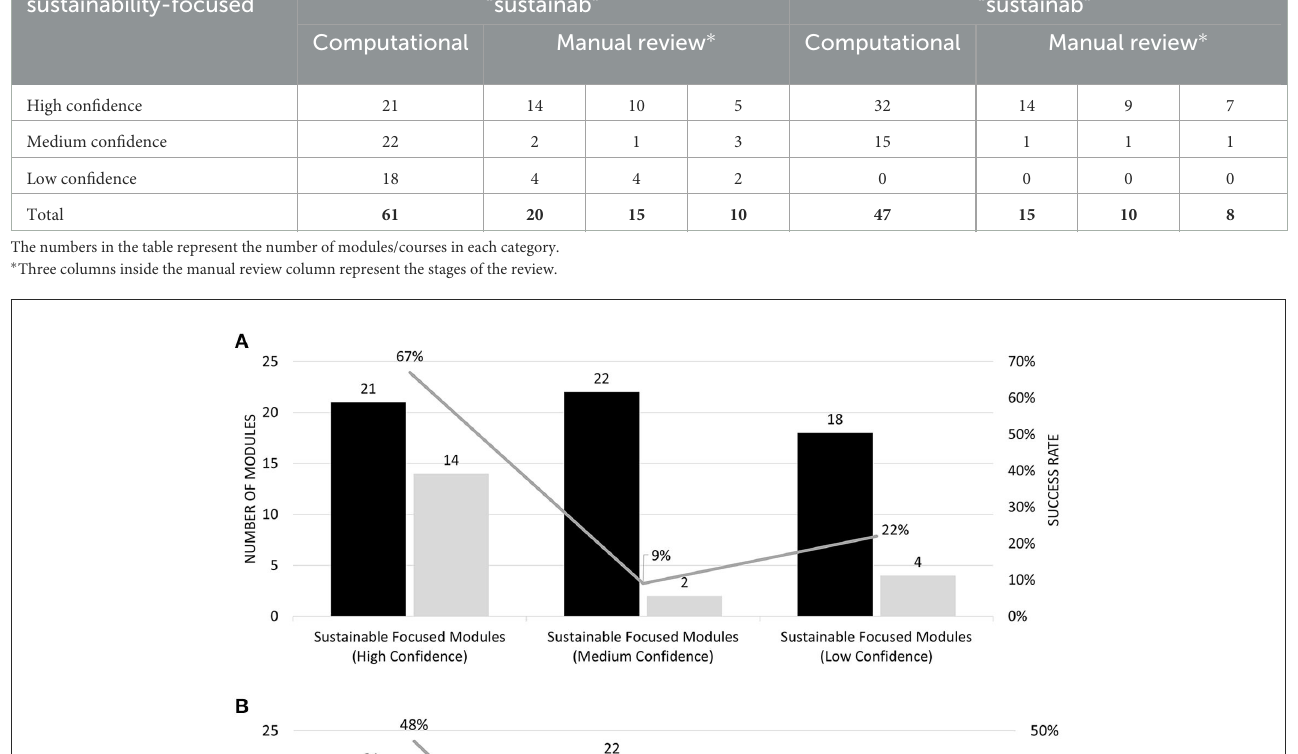
Number of modules/courses without “sustainab”